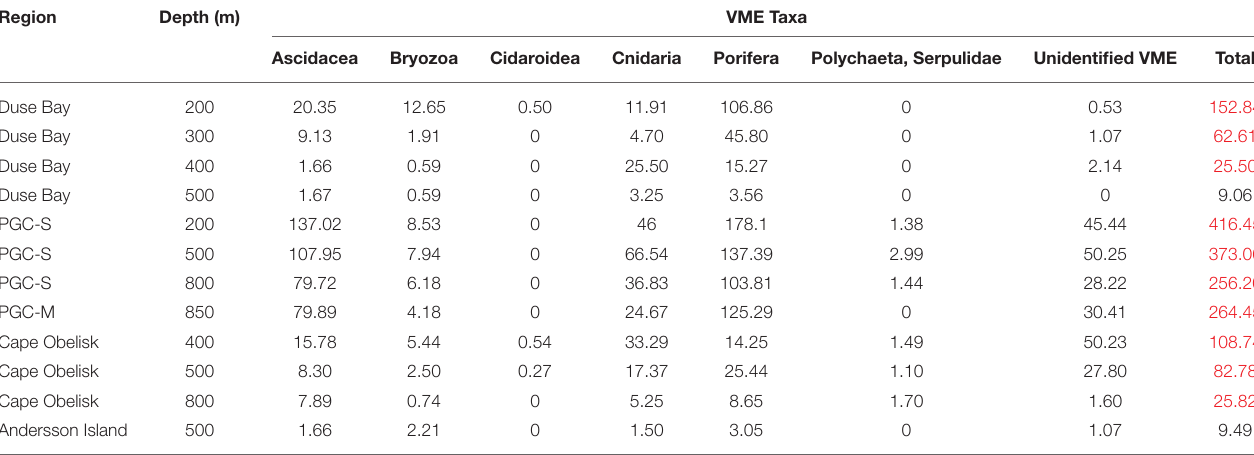
TABLE 5 | Estimated VME taxa wet weight over 1200 m 2 (kg) using mean weights determined for each taxa from AGT data per SUCS deployment site. Region